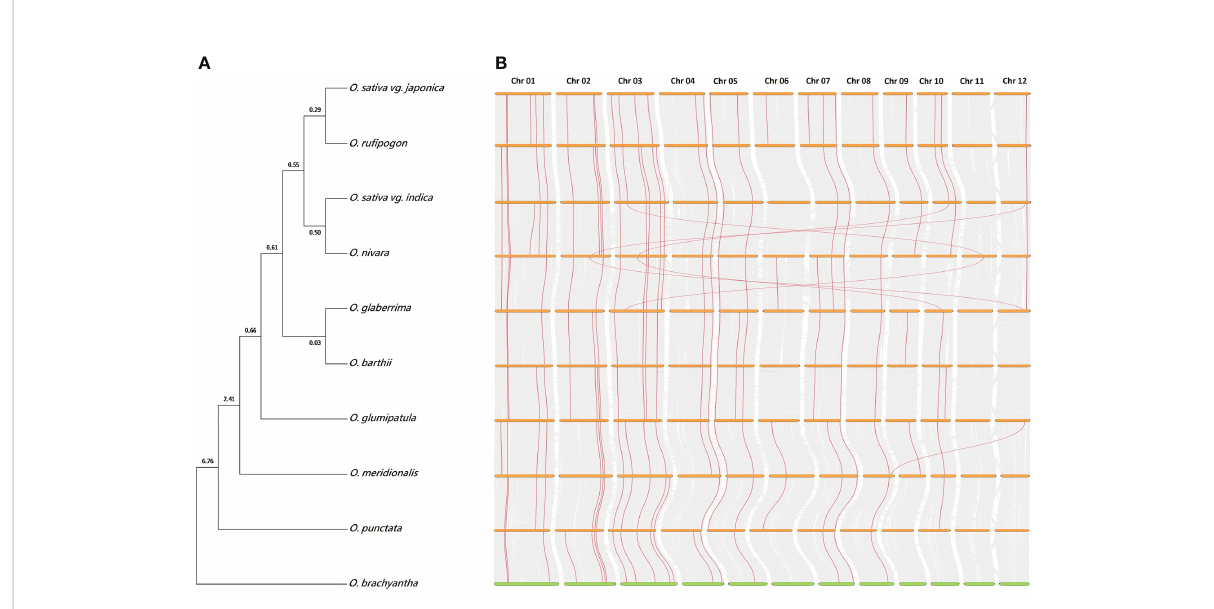
FIGURE 8 Evolutionary phylogenetic relationships and chromosomal synteny analysis among Oryza genomes. (A) Species phylogeny was inferred after MAFFT v7 multiple sequence alignment (Katoh et al., 2018) and neighbor-joining real-time tree creation with MEGA7 (Kumar et al., 2016) using coding sequences of fi ve orthologous Dof genes present across all ten Oryza genomes. O. brachyantha was considered as an outgroup while estimating evolutionary divergence time in million years (above tree nodes). (B) Chromosomal synteny analysis among adjacent species was carried out with TBtools (Chen et al., 2020) by using GFF3 and peptide sequence fi les of ten Oryza genomes. Gene links indicate orthologous Dof genes and their chromosomal locations among different